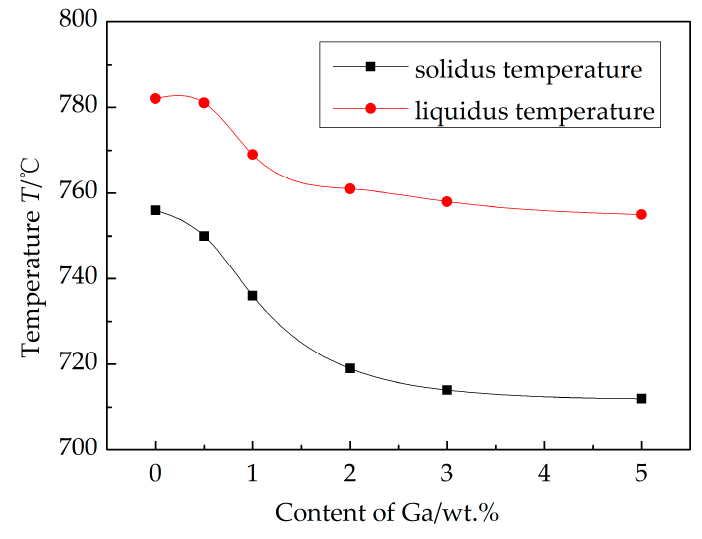
Figure 3. Melting behavior of 12AgCuZnSn-2In-0.15Pr- x Ga filler metals.